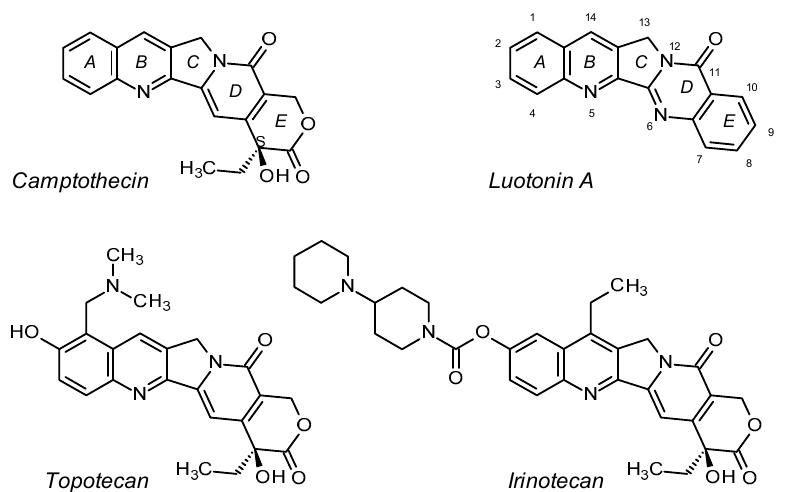
Figure 1. Structures of Camptothecin (CPT), Luotonin A (with IUPAC-conformant numbering scheme) and the CPT-derived drugs, Topotecan and Irinotecan.